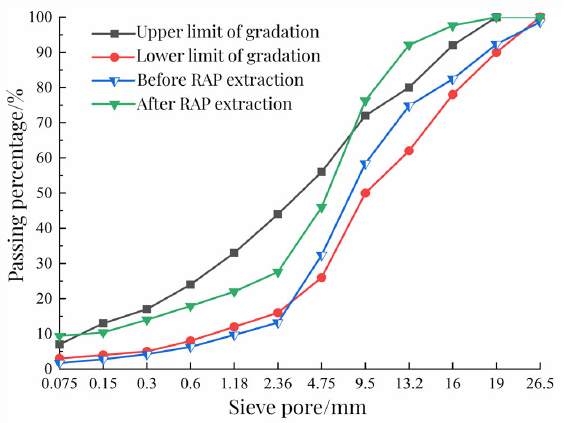
Figure 2. Aggregate gradation before and after RAP extraction. Table 1. Gradation after RAP classi fi cation.